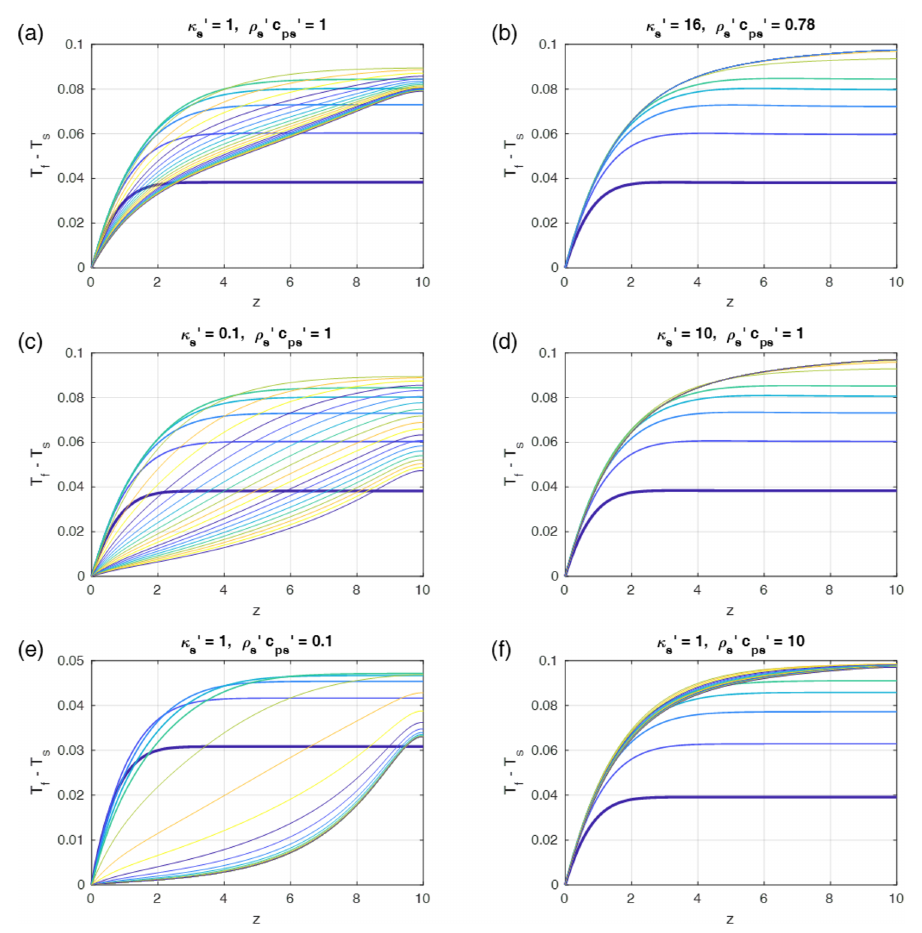
Figure 8. Time- and depth-dependent profiles of the fluid–solid temperature differences as in Fig. 5. (a) Reference models (as in Fig. 5a) with Pe = 1, G = 0 . 1, φ = 0 . 1, and equal fluid-to-solid properties. (b–f) Profiles as in (a) but with solid-to-fluid property ratios as indicated = 1. The properties in (b) are typical for water in sedimentary rocks. In every panel but (b) the first five in the titles of each panel, and λ (cid:48) eff curves were taken with time increments of 0.5 and the later curves with 5. In (b) the first 5 curves were taken with time increments of 0.4875 and the later curves with 4.875. The total time was 100 in all models. Steady state is reached in all